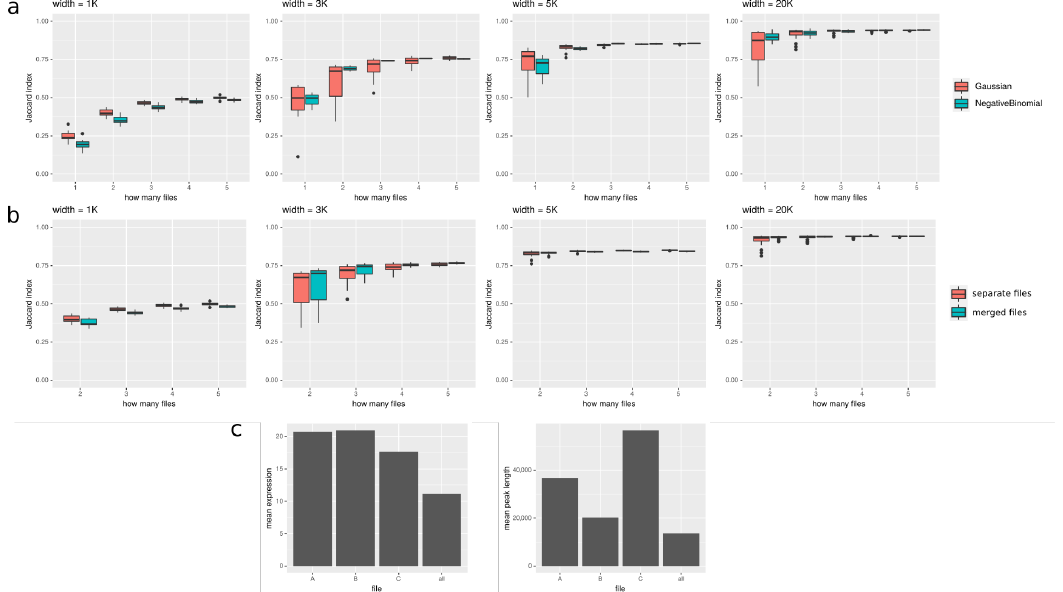
Figure 5. Peakcalling on multiple files; ( a ) and ( b ) are for simulated data, and ( c ) is for real data. ( a ) Plots show how Jaccard index (on y axis) between target and discovered peaks changes depending on number of input files (on x axis). It is shown for 4 various widths of target peaks: 1000, 3000, 5000, and 20,000. ( b ) Comparison of two approaches to using multiple files. One can see that, especially for longer peaks, there is no strong difference between them, while for peak width = 1000, treating files seperately yields better results, and for longer peaks, differences are smaller and sometimes favor merging all the used files. ( c ) Peakcalling on an example tissue from Roadmap Epigenomics (adult liver). Peaks called using all three available files are compared to three sets of peaks called using only single file. The left plot shows the mean expression of genes overlapping with called peaks, and the right one shows mean peak length of called peaks. Using all the files seems to give a conservative consensus peak set; the expression of genes overlapping with peaks called with this approach is substantially lower than the expression of genes overlapping with peaks called on single files, suggesting that using all the files yields more reliable results; at the same time, peaks called on all available files tend to be shorter than those called only on single one, what could result from the inevitable variability between the